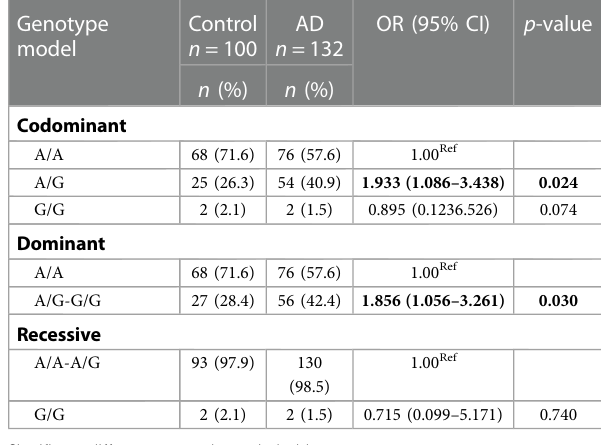
( Table 7 ). There were no signi fi cant differences in IL-6 genotype and allele frequencies between them ( p > 0.05).